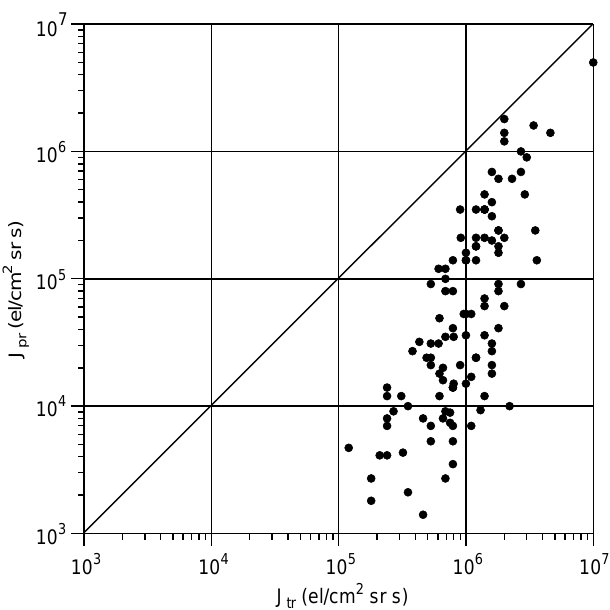
Fig. 2. Relationship between the trapped and precipitating fluxes for the cli(cid:128)-like events